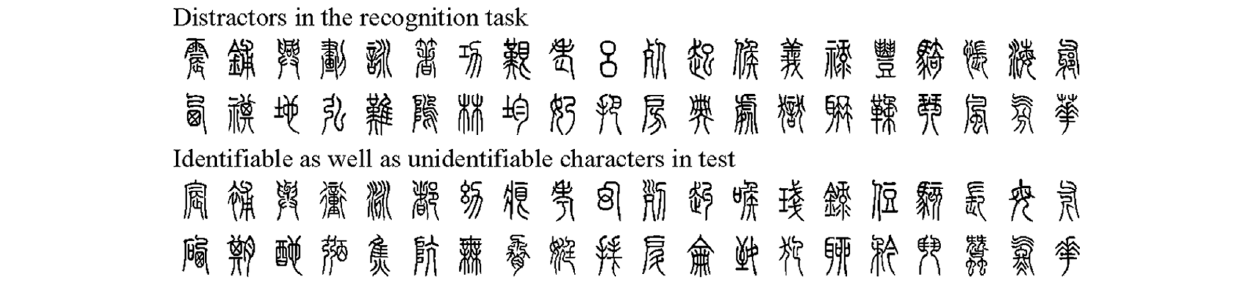
FIGURE 1 | Xiaozhuan font characters used in the current